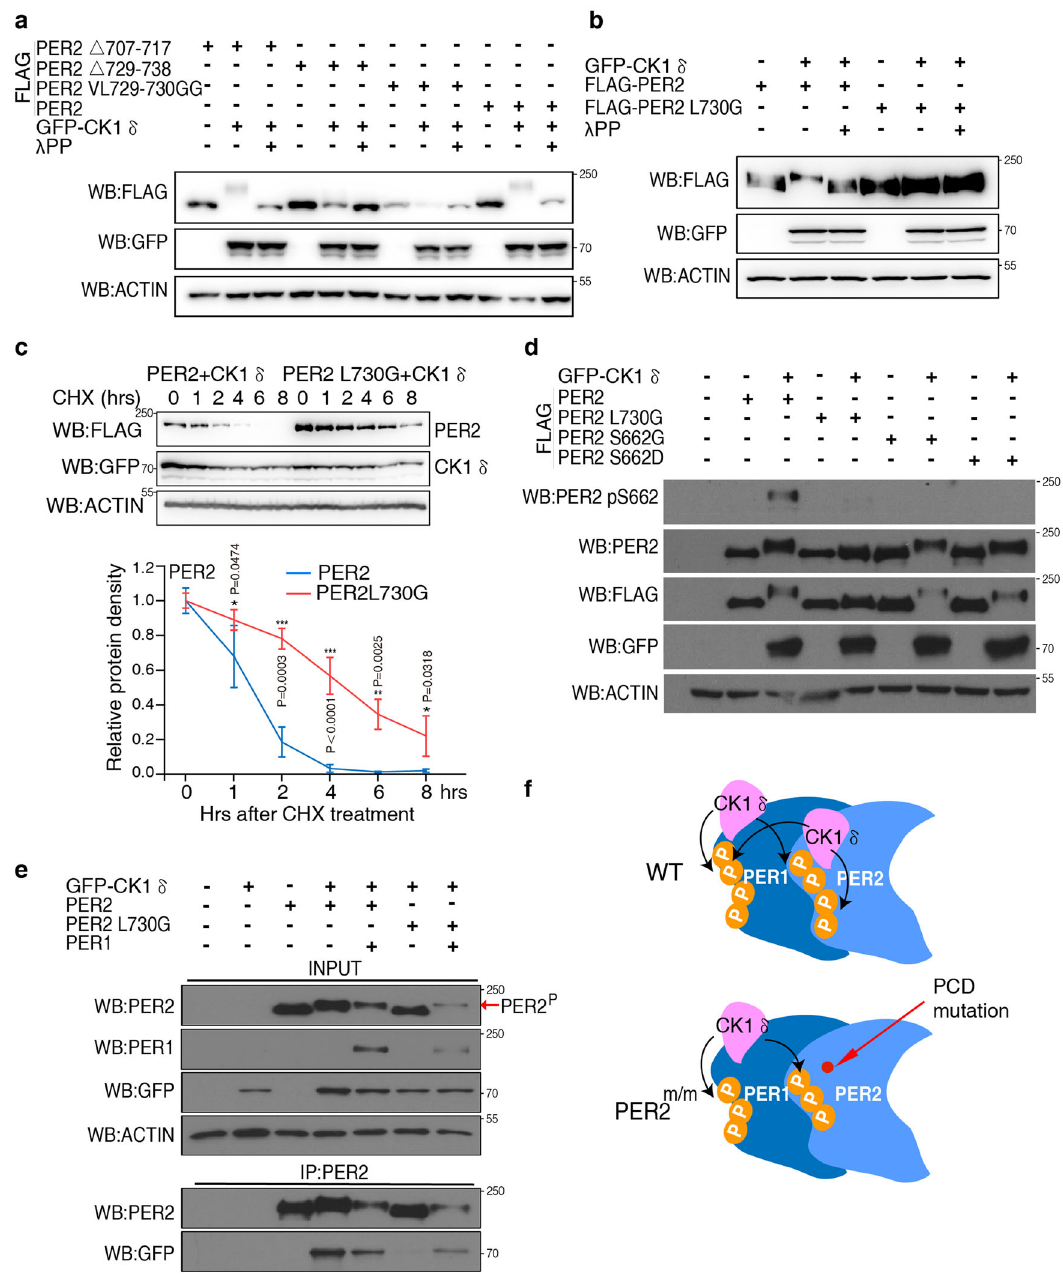
Fig. 2 The stable CK1 δ -PER interaction is required for hPER phosphorylation by CK1 δ and promotes PER degradation. a , b V729G/L730G or L730G mutations of hPER2 abolishes PER2 phosphorylation by CK1 δ in cells. Upshift of hPER2 mobilities indicate its phosphorylation by CK1 δ . Indicated samples were treated with lambda phosphatase to con fi rm the mobility shifts were due to phosphorylation. 1.5 μ g of hPER2 and 1 μ g of CK1 δ plasmids were transfected per 35 mm dish of HEK293 cells. The low PER2 levels in lane 5 and 7 are due to variations in transfect experiments. Three independent experiments were performed to validate the results. c CHX treatment showing that the L730G mutation dramatically slows down hPER2 turnover rate. Western blot result of a representative experiment showing the levels of hPER2 after the addition of CHX (10 μ g/ml) (top). ( n = 3). Densitometric analysis of three independent experiments of the Western blot results (bottom). * and *** indicate p value < 0.05 and 0.001 (two-sided t -test), respectively, at the indicated time points. Data are represented as mean ± SD. d Western blot analysis showing the hPER2 L730G mutation abolished hPER2 S662 phosphorylation. Three independent experiments were performed to validate the results. e Immunoprecipitation assays and western blot analysis showing that hPER2 L730G can be phosphorylated by CK1 δ when hPER1 was co-expressed. The co-expression of hPER1 results in immunoprecipitation of hPER2 L730G with CK1 δ . The phosphorylated hPER2 species are indicated by the arrow. See also Fig. S2. Three independent experiments were performed to validate the results. f A diagram showing the model that CK1 uses PER as a scaffold to phosphorylate different PER proteins in the complex.